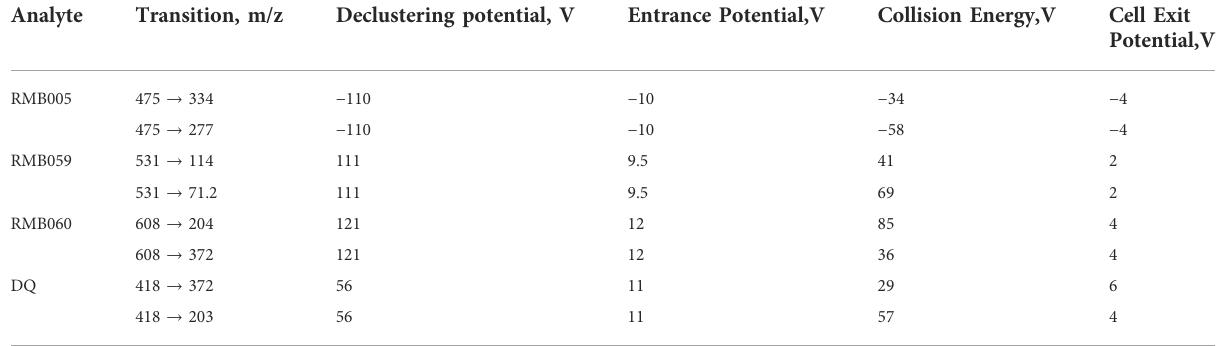
TABLE 1 Multiple reaction monitoring transitions and fi nal mass spectrometer conditions. Analyte